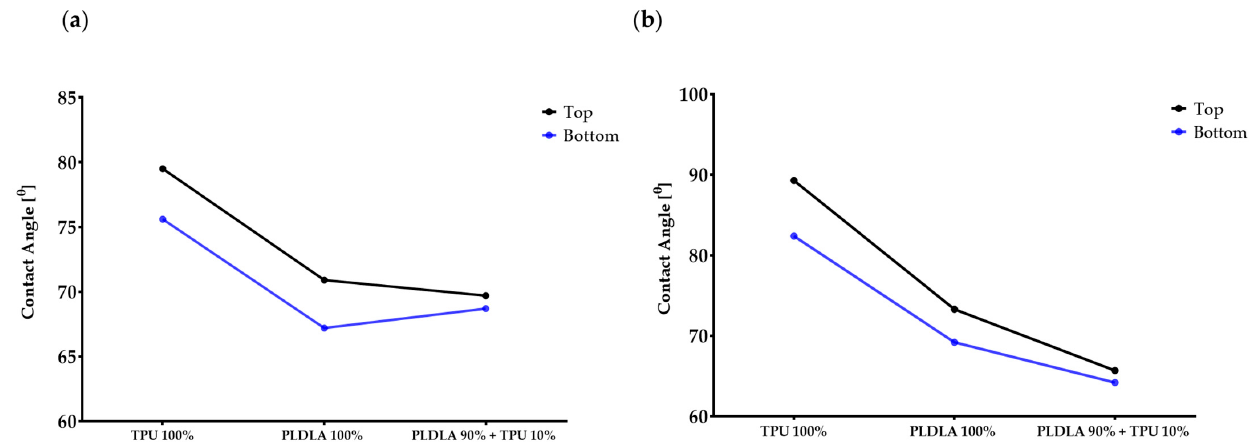
Figure 1. The contact angle measurements of the water and Diiodomethane dropped on polystyrene Petri dishes with TPU/PLA and TPU/PLA/CsA films. ( a ); water contact angle, ( b ); diiodomethane contact angle.